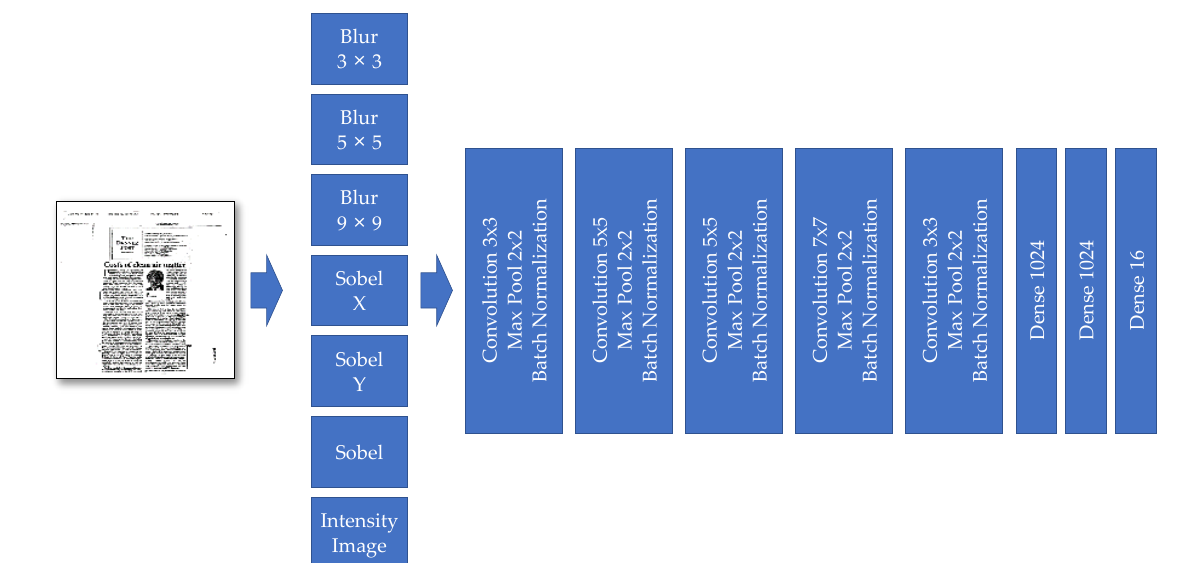
Figure 6. The “ Model II ” developed for document image classification. Figure 6. The “Model II” developed for document image classification.